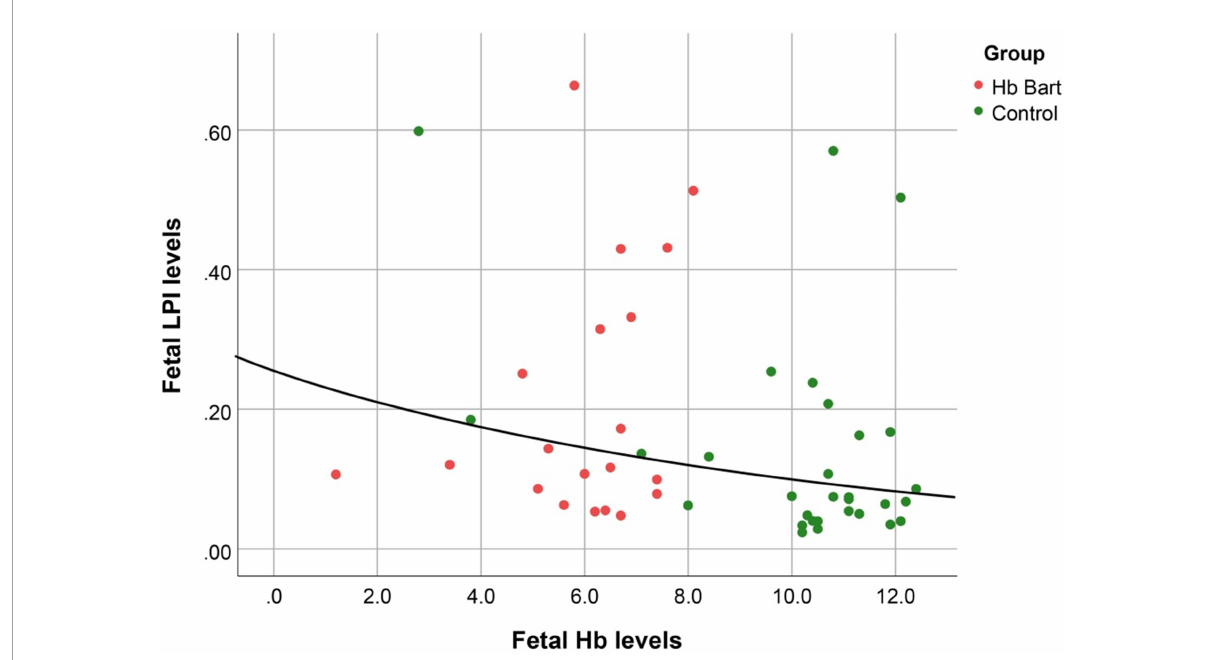
FIGURE1 The correlation between fetal LPI (Labile Plasma Iron) levels and fetal hemoglobin levels (Exponential function; R 2 : 0.095; p : 0.030).